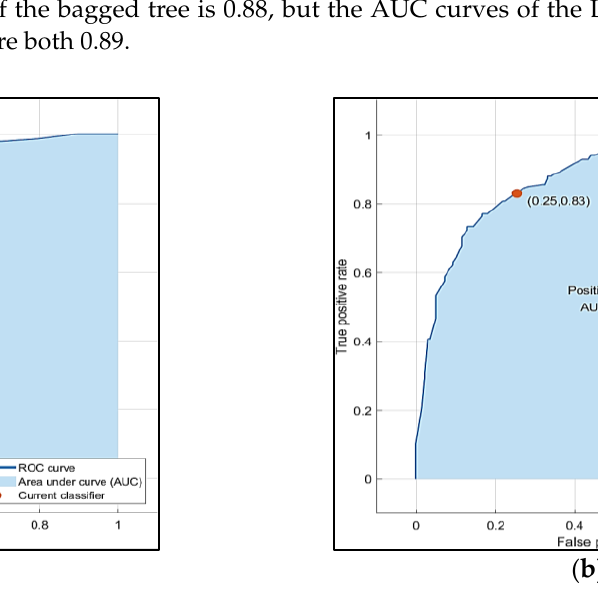
Figure 12. ( a ) Bagged tree model ROC curve corresponding to class 0. ( b ) Bagged tree model ROC curve corresponding to class 1.